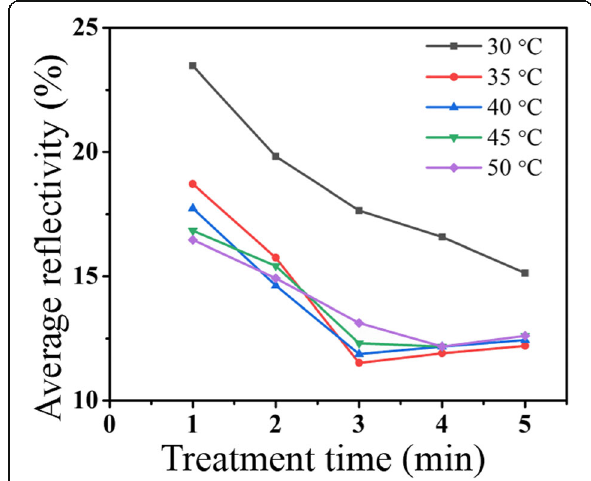
Fig. 3 Average reflectivity nanoporous silicon dependence of time at specific temperatures. Average reflectivity of nanoporous silicon structures dependence of time for treatment at 30, 35, 40, 45, and 50 °C, respectively